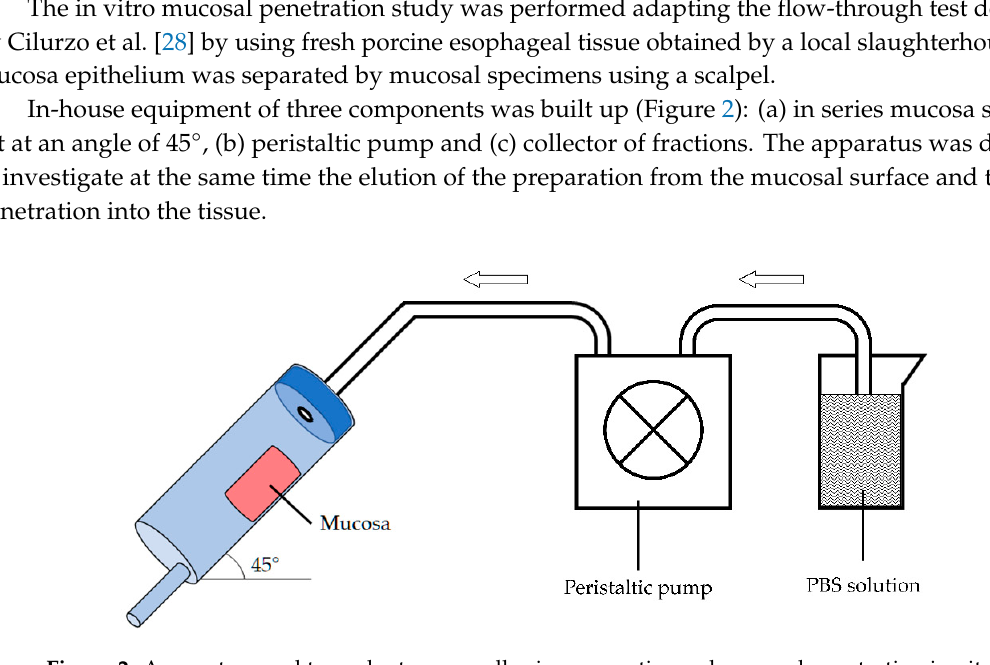
Figure 2. Apparatus used to evaluate mucoadhesive properties and mucosal penetration in vitro.